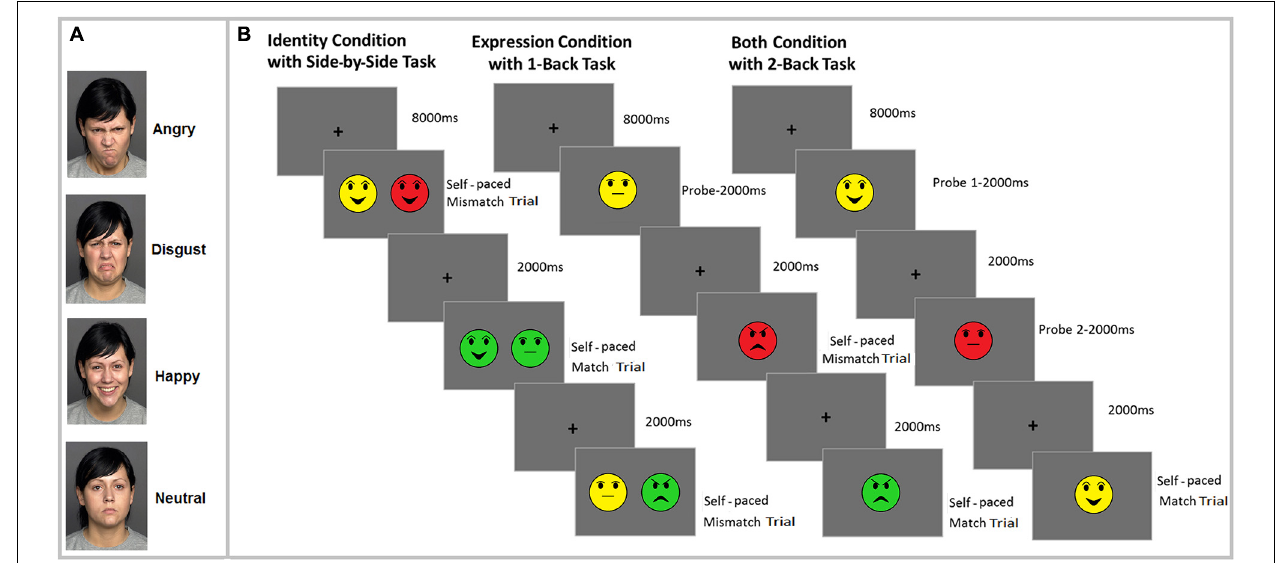
FIGURE 1 | Illustration of the one of the faces with all emotional expressions (angry, disgust, happy, neutral) used in the study (A) and the experimental procedure, with a sample N -Back task for each of the